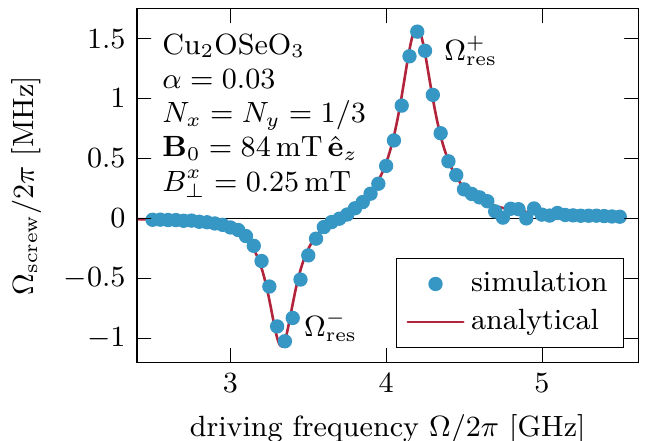
Figure 3: Ω as a function of Ω from simulations and analytical calculations. The screw parameters γ = − 1.76 × 10 11 T − 1 s − 1 , J = 7.09 × 10 − 13 J m − 1 , D = 7.42 × 10 − 5 J m − 2